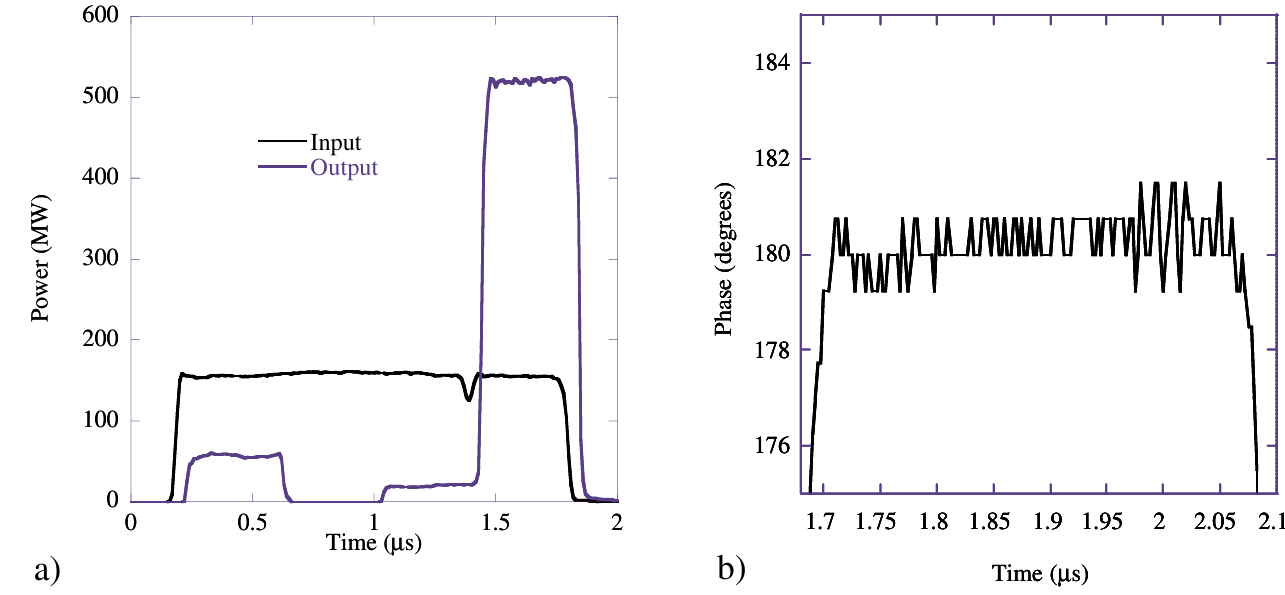
FIG. 27. (Color) System response after low-level rf correction is applied. (a) Power levels and (b) close-up view for the phase of the output